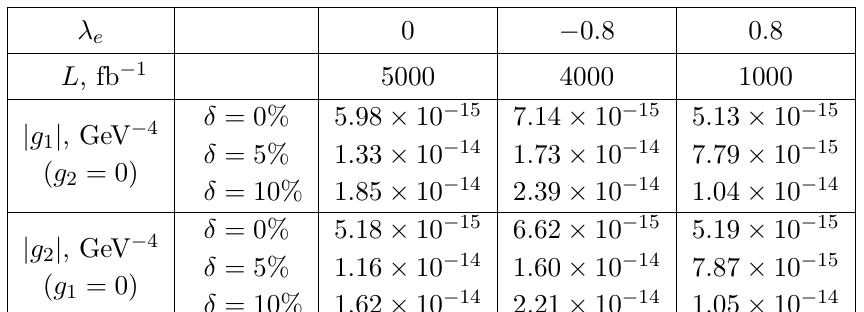
Table 2 . The same as in table 1, but for the energy integrated